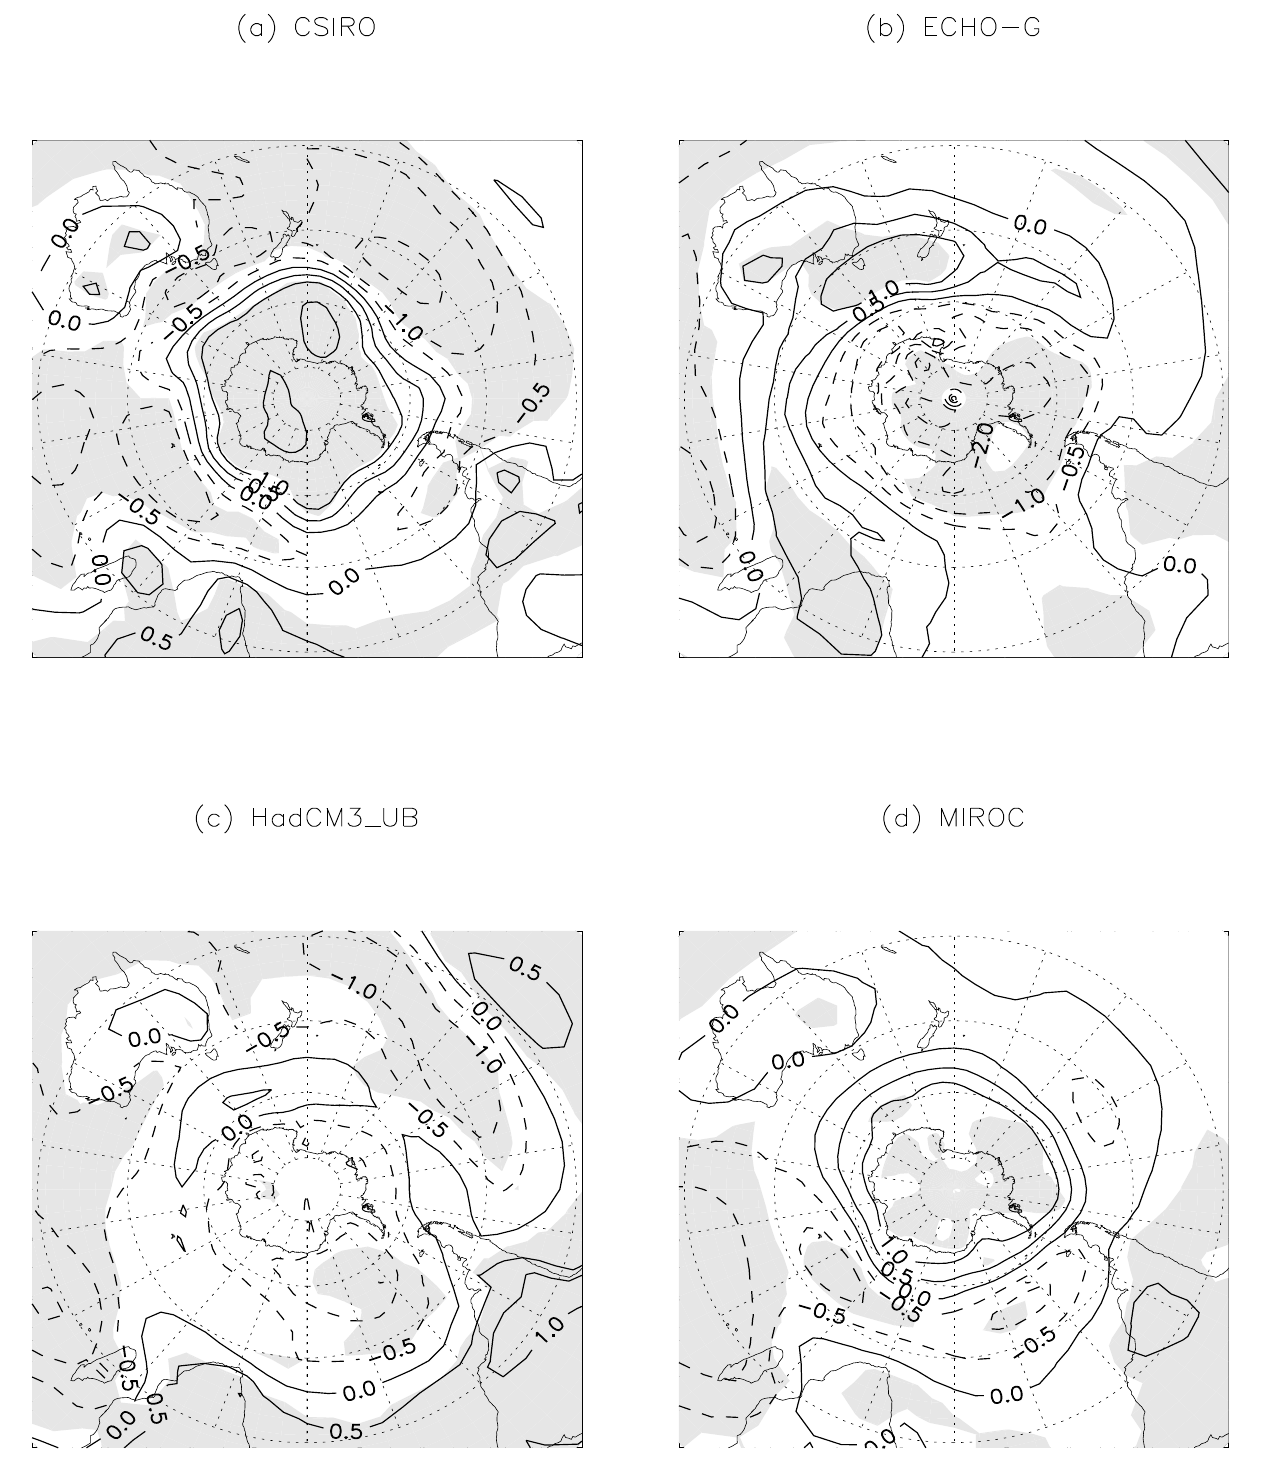
Fig. 3. The difference in DJF mean sea level pressure (hPa) for the Mid-Holocene relative to the pre-industrial control run for (a) CSIRO Mk3L, (b) ECHO-G, (c) HadCM3 UB and (d) MIROC. Solid (dashed) contours indicate positive (negative) changes in pressure. Statistically significant changes in SLP (p ≤ 0.05) are shaded grey.